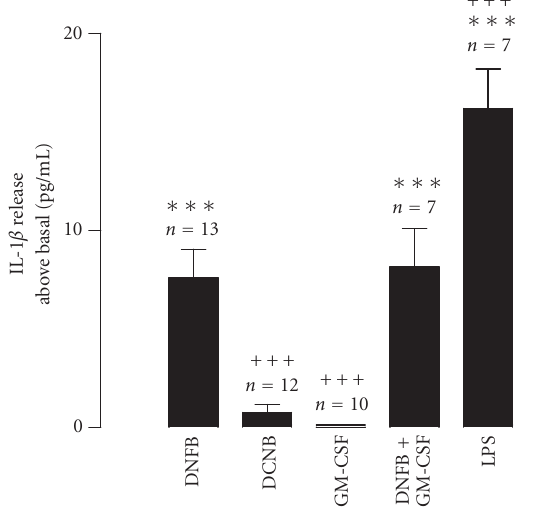
Figure 1. IL-1 β release induced by DNFB in a fetal skin dendritic cell line. Cells were stimulated with 2,4- dinitrofluorobenzene (DNFB, 1 µ g/mL) or with 2,4- dichloronitrobenzene (DCNB, 1 µ g/mL), for 30 minutes. Alternatively, cells were stimulated with GM-CSF (10ng/mL) alone, or in association with DNFB, for the same time period. As a positive control, the cells were stimulated with LPS (40 µ g/mL), for 12 hours. IL-1 β was quantified with an ELISA kit. Data express the IL-1 β release above the basal secretion. Each value represents the mean ± SEM from the indicated number of experiments, performed in duplicate. Statistical significance was calculated by the one-way ANOVA test with a Bonferroni post-test ( ∗∗∗ P < . 001 as compared to the control; +++ P < . 001 as compared to stimulation with DNFB).